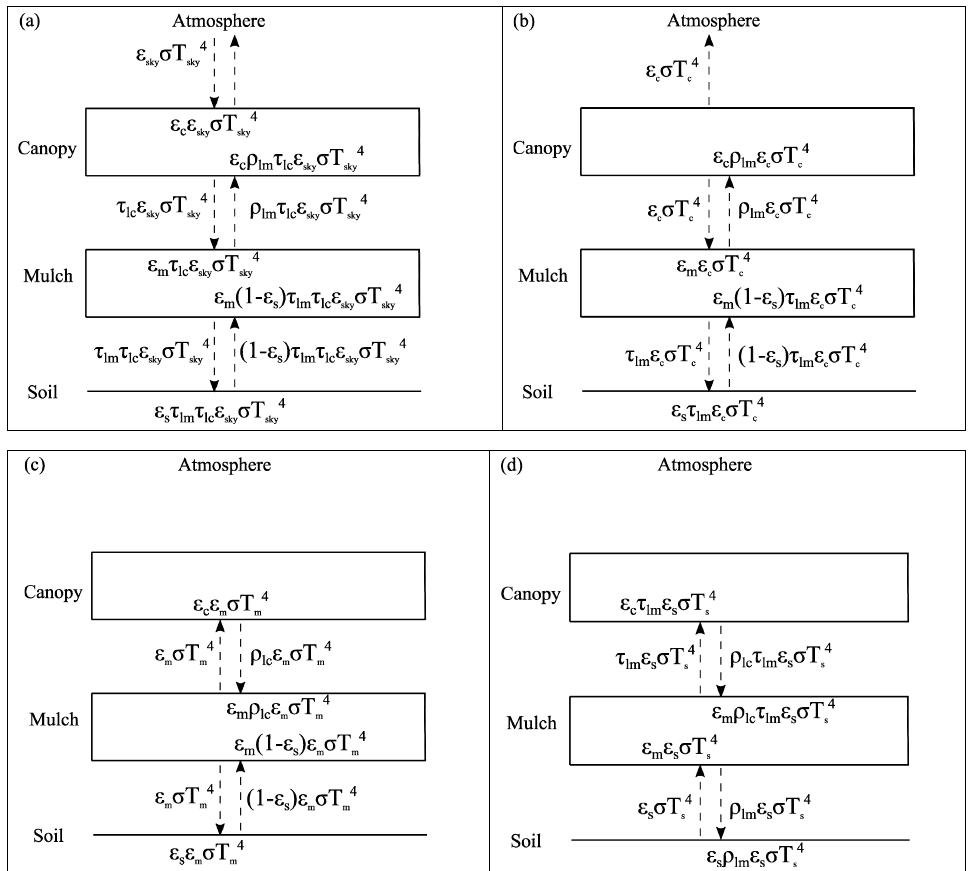
Figure 4. Schematic diagram of emitted longwave radiation transfer between the potato canopy, plastic film mulch, and soil surface from: ( a ) the atmosphere, ( b ) the potato canopy, ( c ) the plastic film mulch, and ( d ) the soil surface ( σ is the Stefan-Boltzmann constant; T sky , T c , T m , and T s are the temperatures of the sky, plant canopy, plastic film mulch, and soil surface, respectively; ε sky , ε c , ε m , and ε s are the emissivities (or infrared absorptances) of the sky, plant canopy, plastic film mulch, and soil surface, respectively; ρ lm and ρ lc are the longwave reflectances of the plastic film mulch and plant canopy, respectively; and τ lc and τ lm are the longwave transmittances of the plant canopy and plastic film mulch,